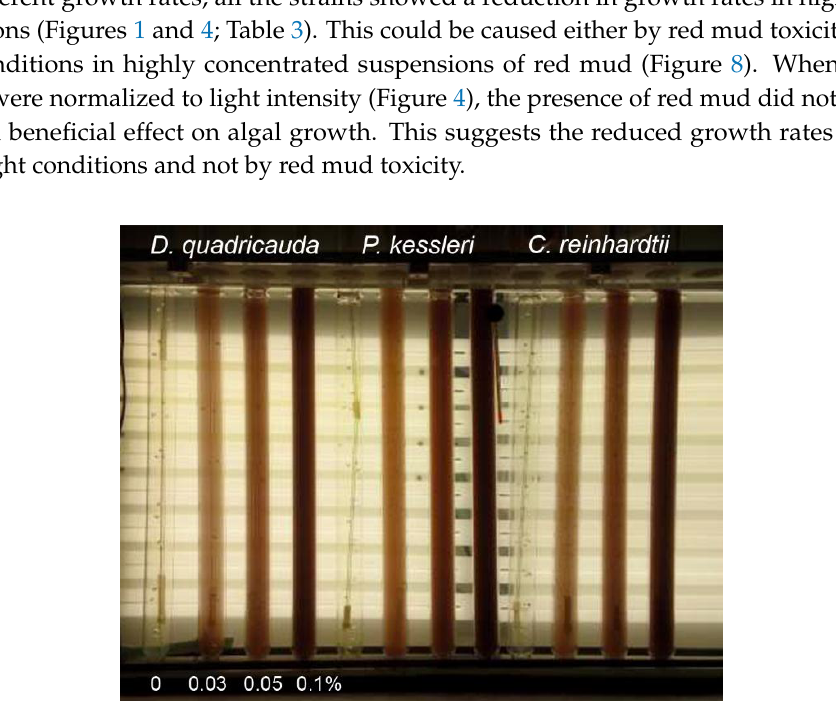
Table 4. Composition of nutrient media for all experimental species. Compound